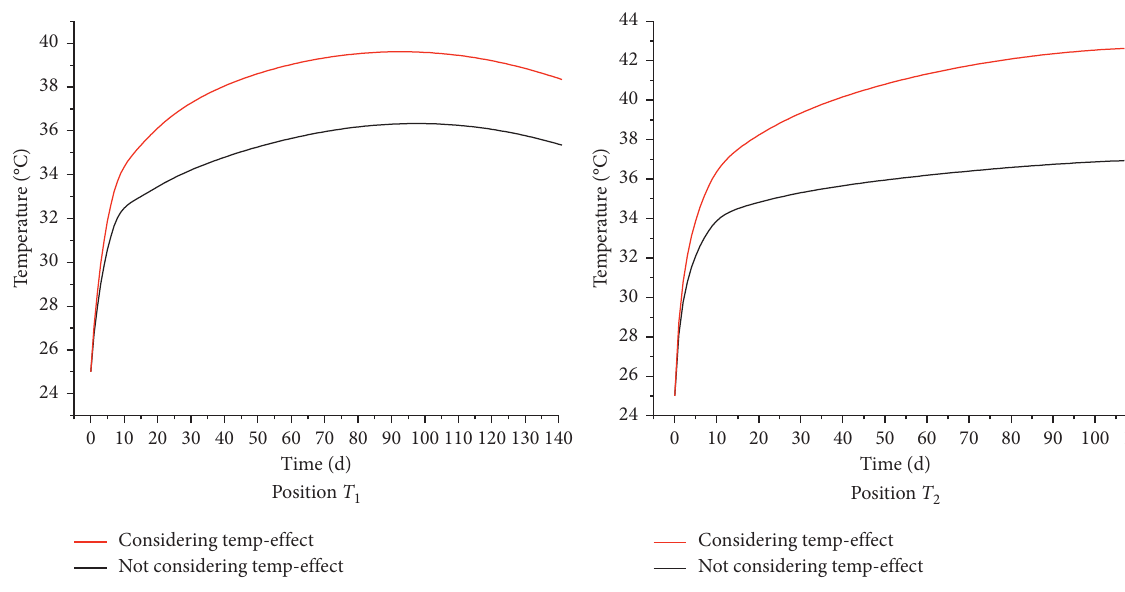
Figure 4: Temperature history curve of position T